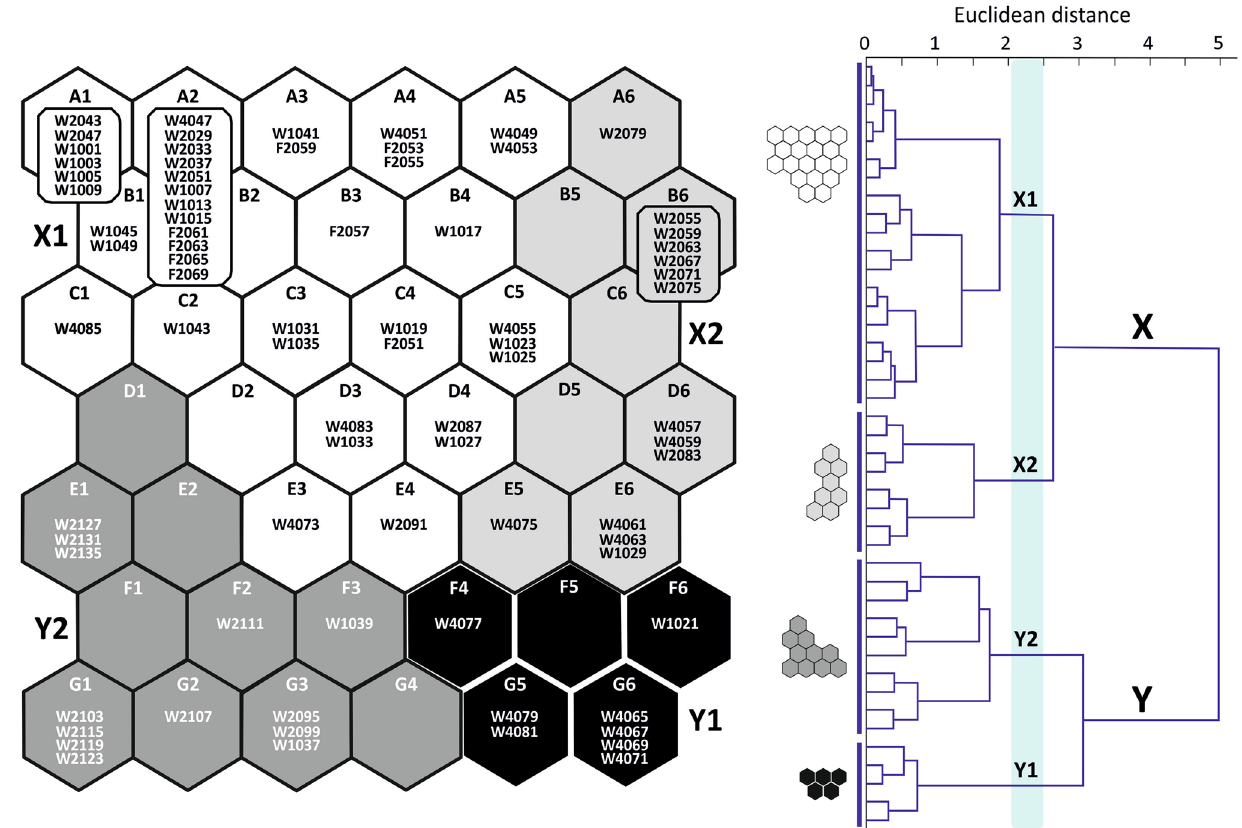
Figure 3. Seventy nine non-empty core samples assigned to 42 self-organising map (SOM) output neurons (A1–G6). The neurons are arranged into a two-dimensional lattice (7 × 6). Clusters (X and Y) and subclusters (X1, X2, Y1 and Y2; shown in different degrees of greyness) of neurons have been identified with the use of hierarchical cluster analysis. Sample codes are arranged as follows: first two signs stand for core symbol (W1— RP W1, W2—RP W3(2), W4—RP W3(4), F2—RP F2), followed by numbers referring to depth (in cm